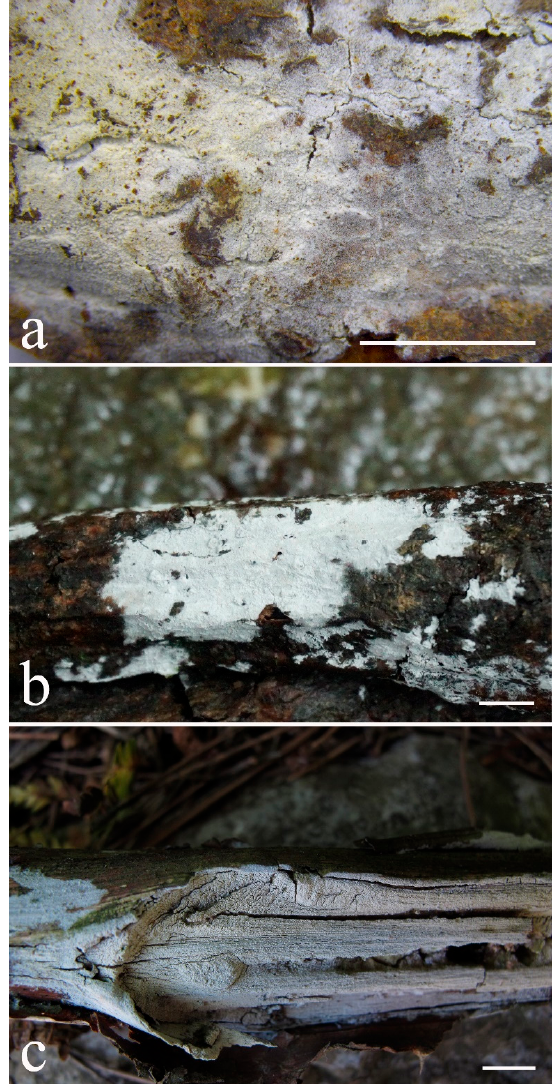
Figure 18. Basidiocarps of Lyomyces leptocystidiatus . ( a , b ) LWZ 20170814-14 (holotype); ( c ) LWZ 20170818-9 (paratype).—Scale bars: a = 5 mm; b , c = 1 cm.